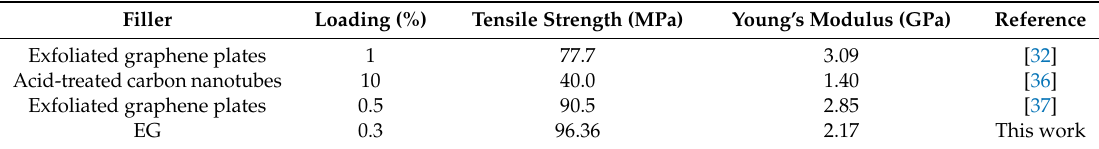
Table 1. Comparison of literature data with this work for the mechanical properties of PA66 composites .